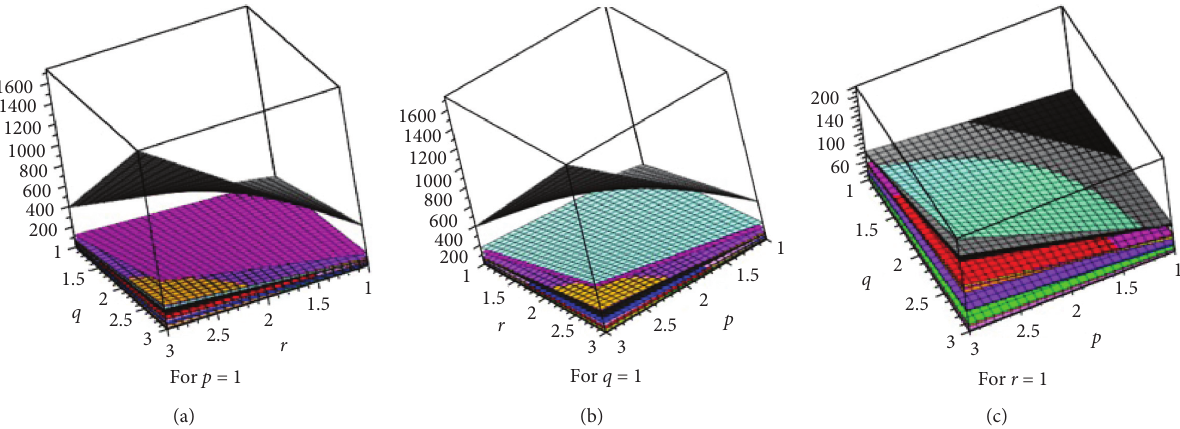
Figure 15: The comparison of all irregularity indices for crystallographic structure of titanium difluoride T